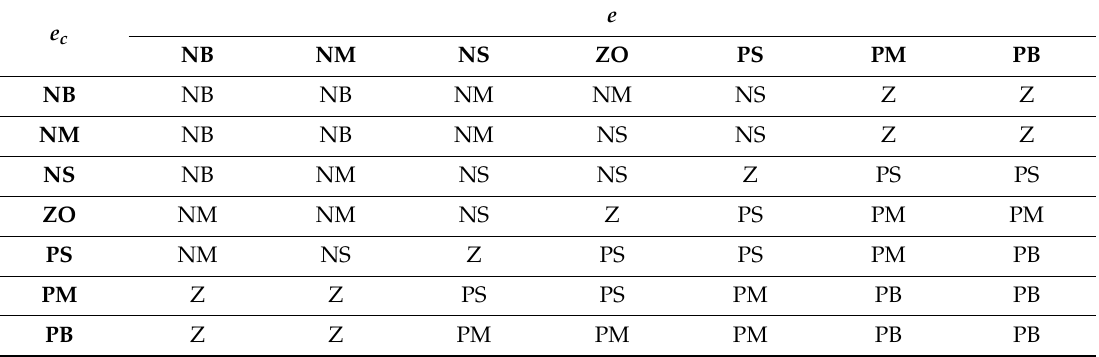
Table 2. Fuzzy rule of K i